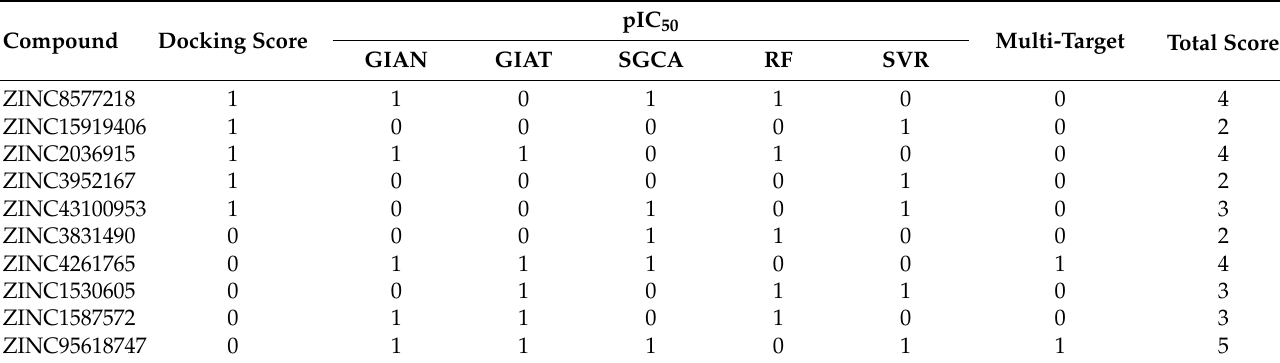
Table 4. Vote scores of the top 10 candidates a .